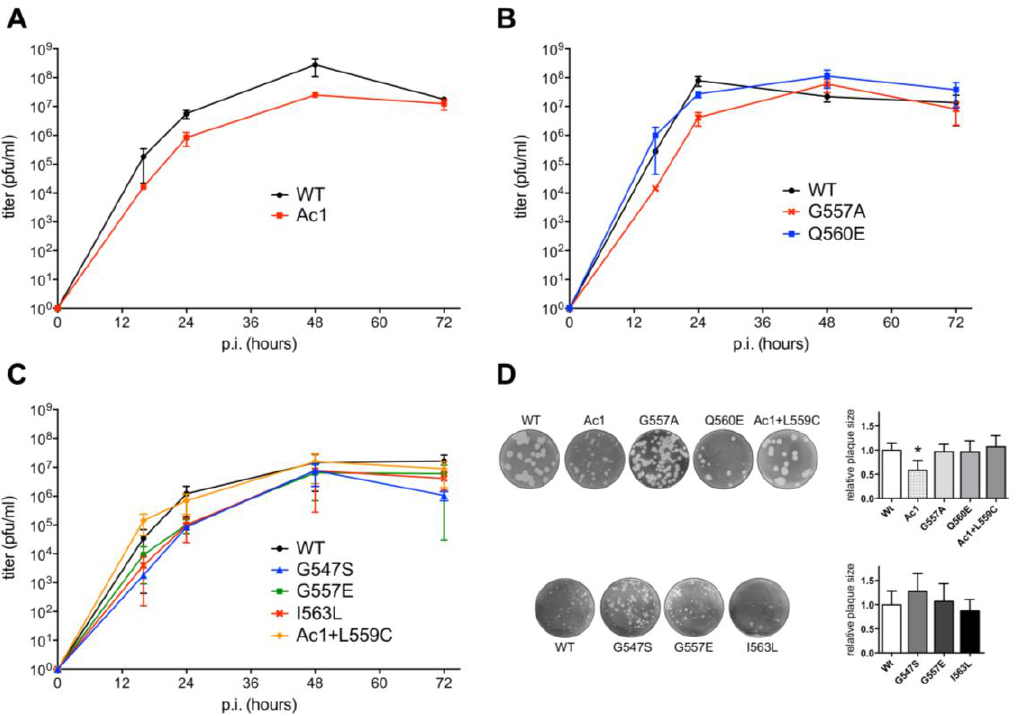
Figure 3. Growth kinetics of recombinant influenza viruses with mutations in HA. ( A – C ) MDCK cells were infected with the indicated virus at an m.o.i. of 0.001 (A) or m.o.i. of 0.01 ( B,C ). Aliquots were removed from the supernatant at 16, 24, 48 and 72 h p.i. and titers were determined by plaque assay. Experiments were carried out in triplicate and are displayed as means ± standard error. Note that due to the inherent variability of growth experiments titers of wild type (WT) virus somewhat varied between experiments. To account for this variability we always included wild type virus in growth experiments, i.e. , all the growth curves shown in one graph were done in parallel. ( D ) Plaque assays of wild type WSN and WSN carrying the indicated HA mutations. Plaque assays of each row were performed in parallel, i.e. , with sister cultures infected and stained at the same time. Diameters of 20–40 plaques were measured using ImageJ and normalized to wild-type virus, which was analyzed in parallel. A student’s t -test was performed to determine a statistical significant difference between (relative) plaque diameters, However, only the mutant Ac1 produced consistently smaller plaques indicated by the asterisk ( p < 0.05).